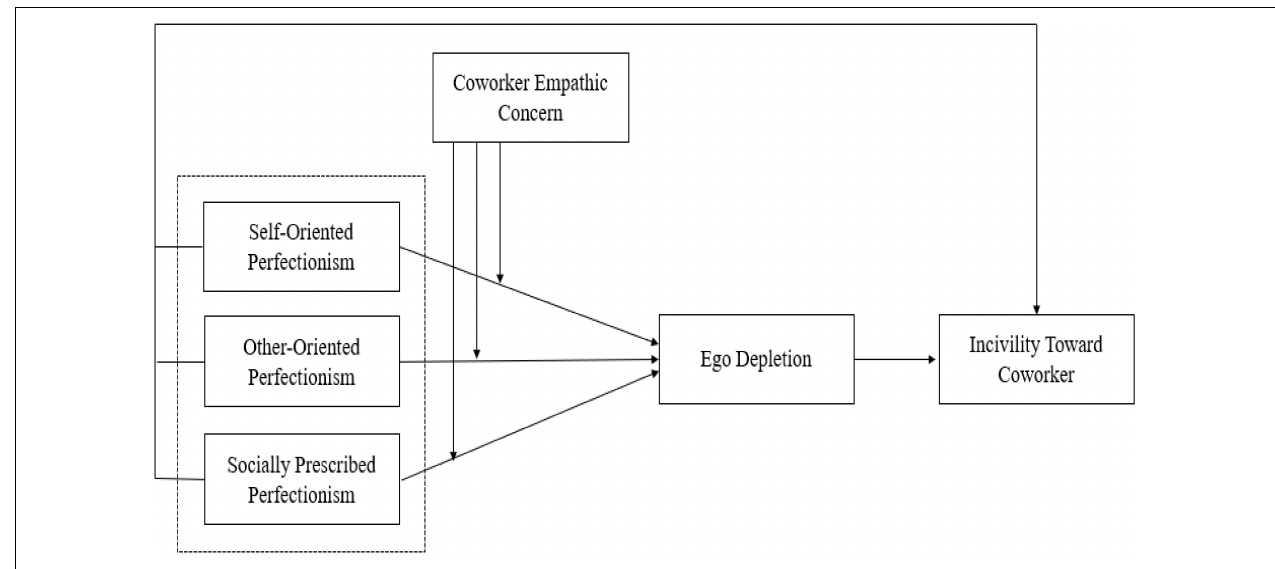
FIGURE 1 | Theoretical